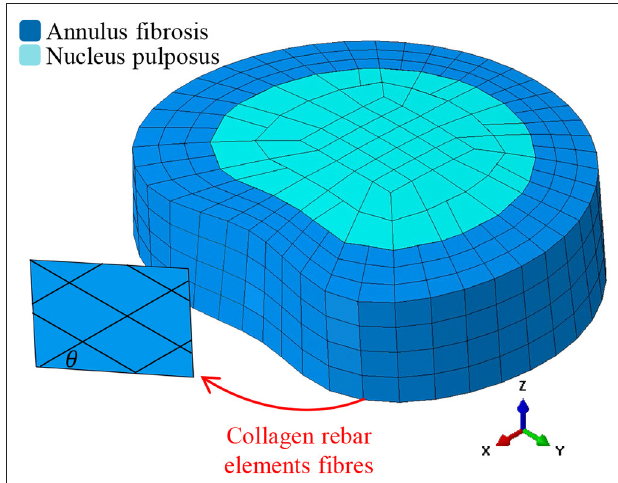
FIGURE 1 | Schematic representation of the IVD finite element model.